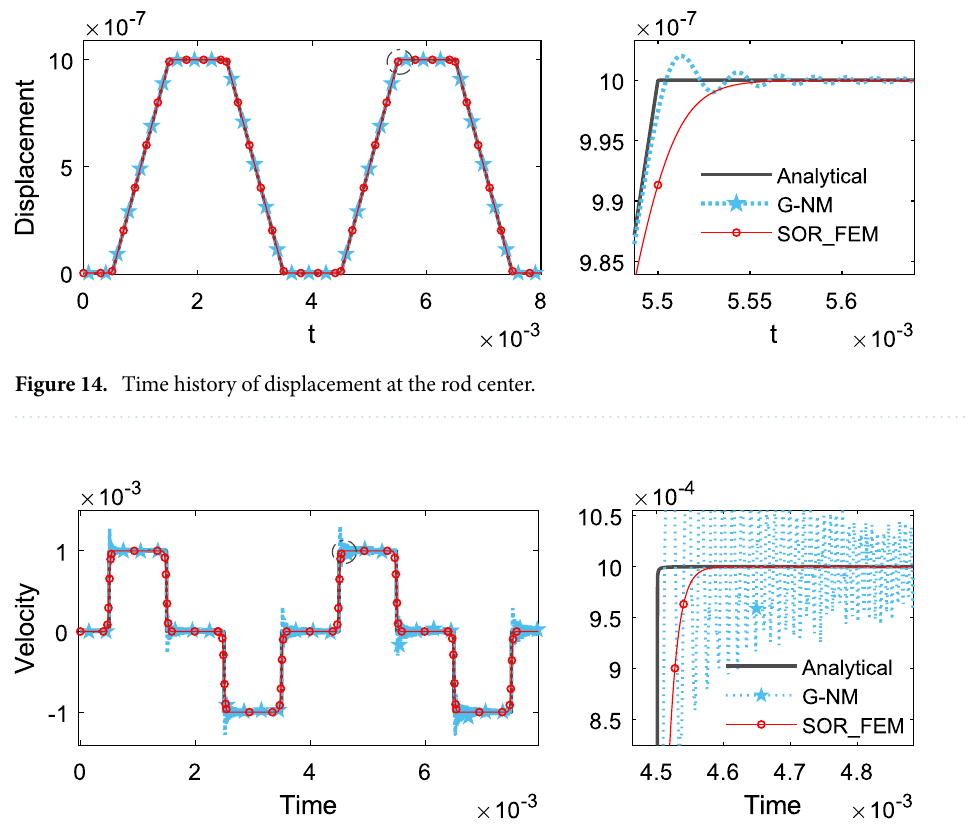
Figure 15. Time history of velocity at the rod center.